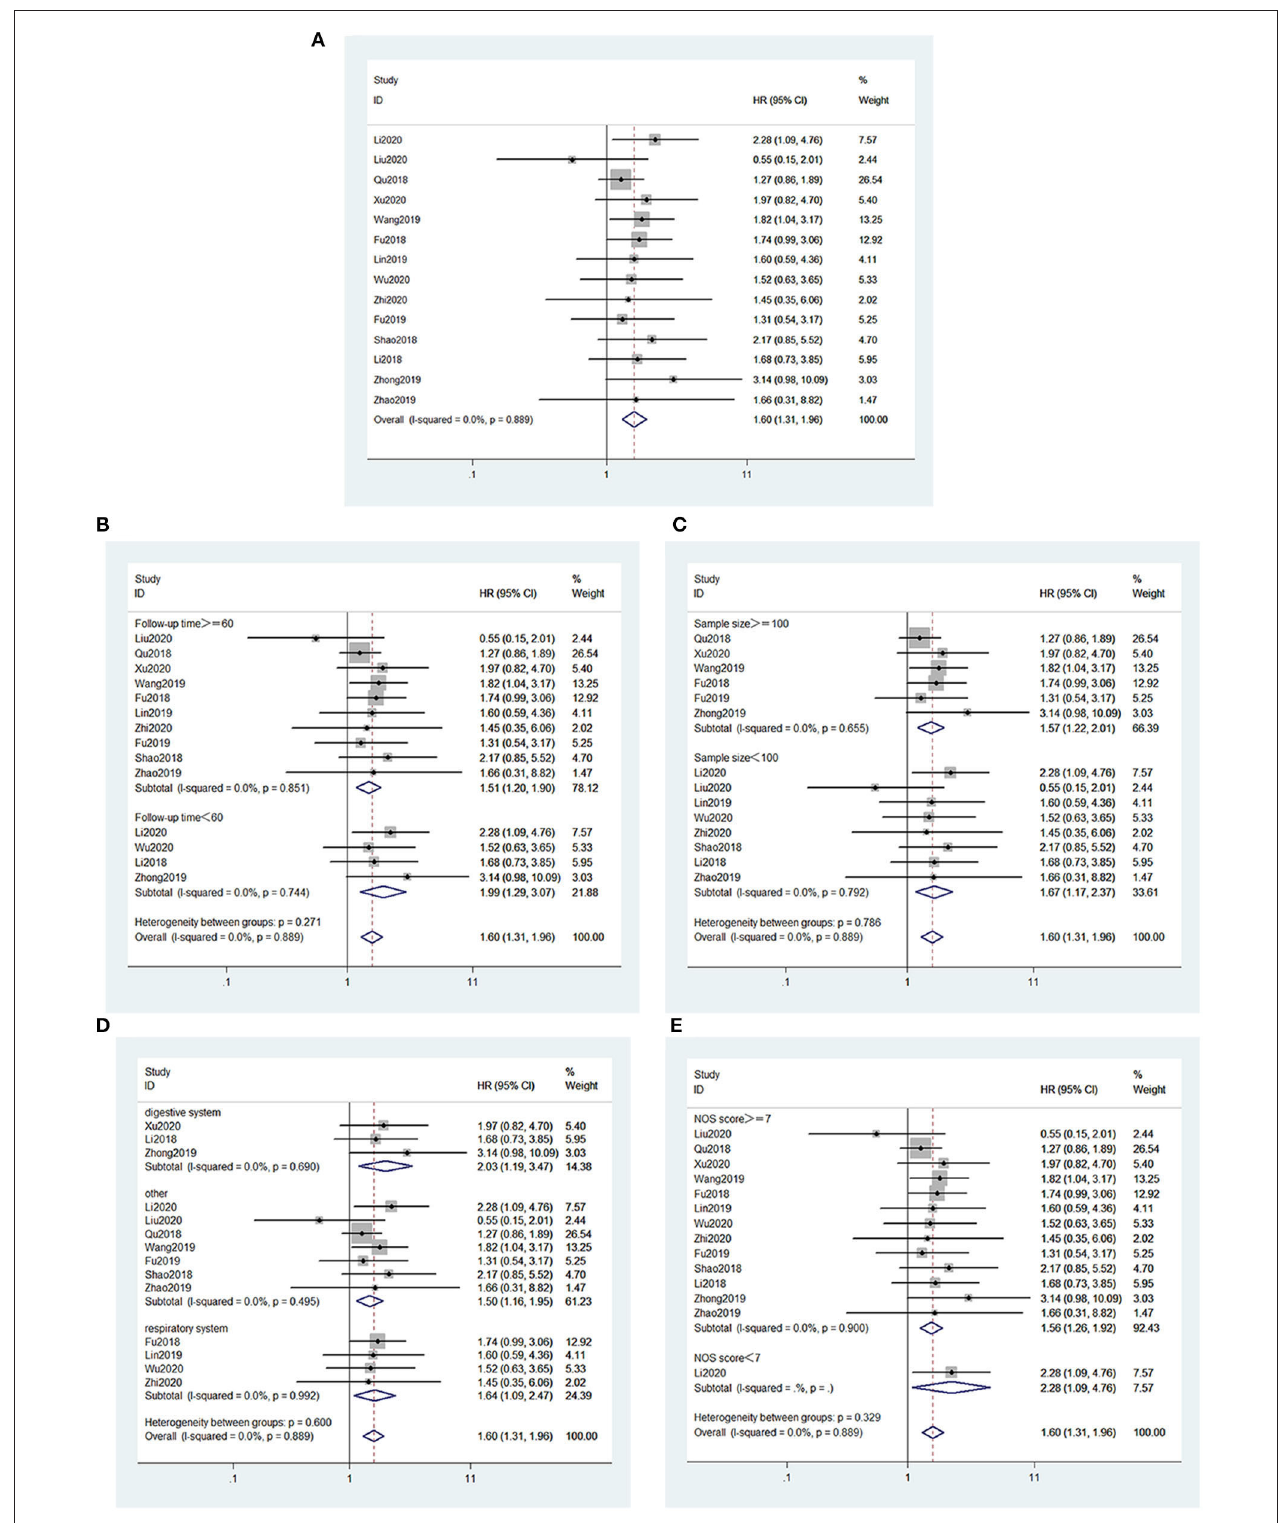
FIGURE 2 | Forest plots for the association of MIAT expression with overall survival and subgroup analysis of MIAT expression with overall survival. (A) Forest plots for the association of MIAT expression with overall survival. (B) Subgroup analysis stratified by follow-up time. (C) Subgroup analysis stratified by sample size. (D) Subgroup analysis stratified by type of cancer. (E) Subgroup analysis stratified by NOS score.